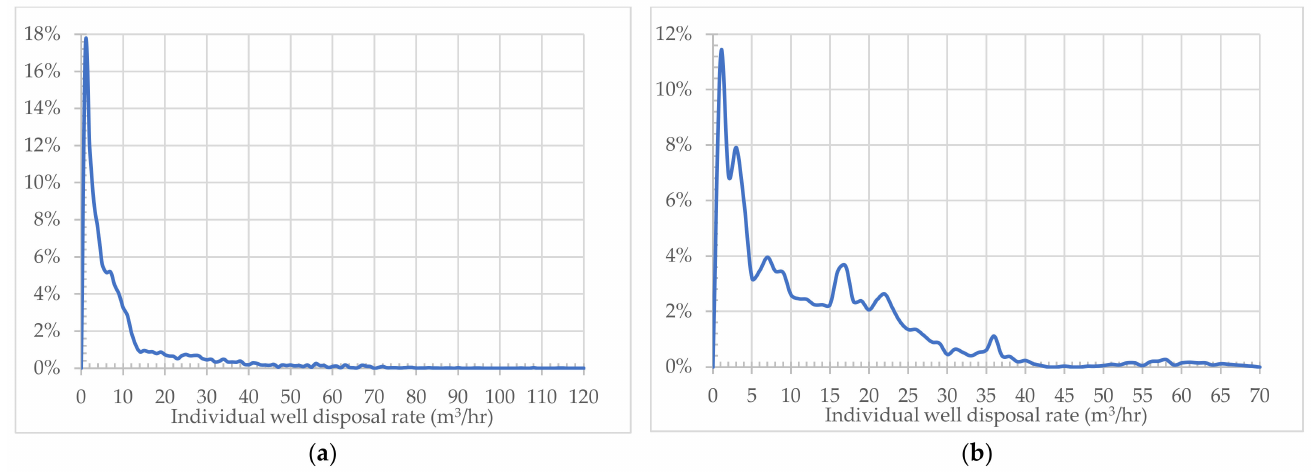
Figure A21. Historical per-well water injection rate ( X -axis) frequency ( Y -axis) distributions (January 1962–December 2022) in ( a ) the Debolt Formation; ( b ) the Livingstone